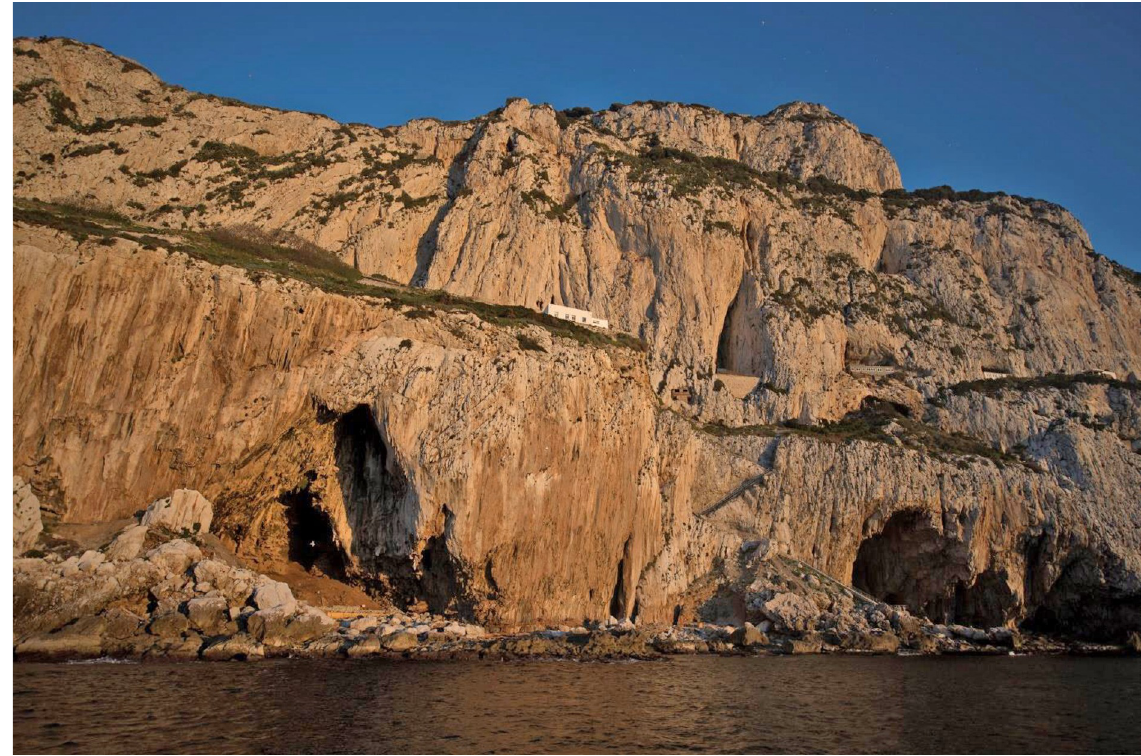
Fig 4. Gorham’s Cave at the base of Mons Calpe (Gibraltar) from the sea